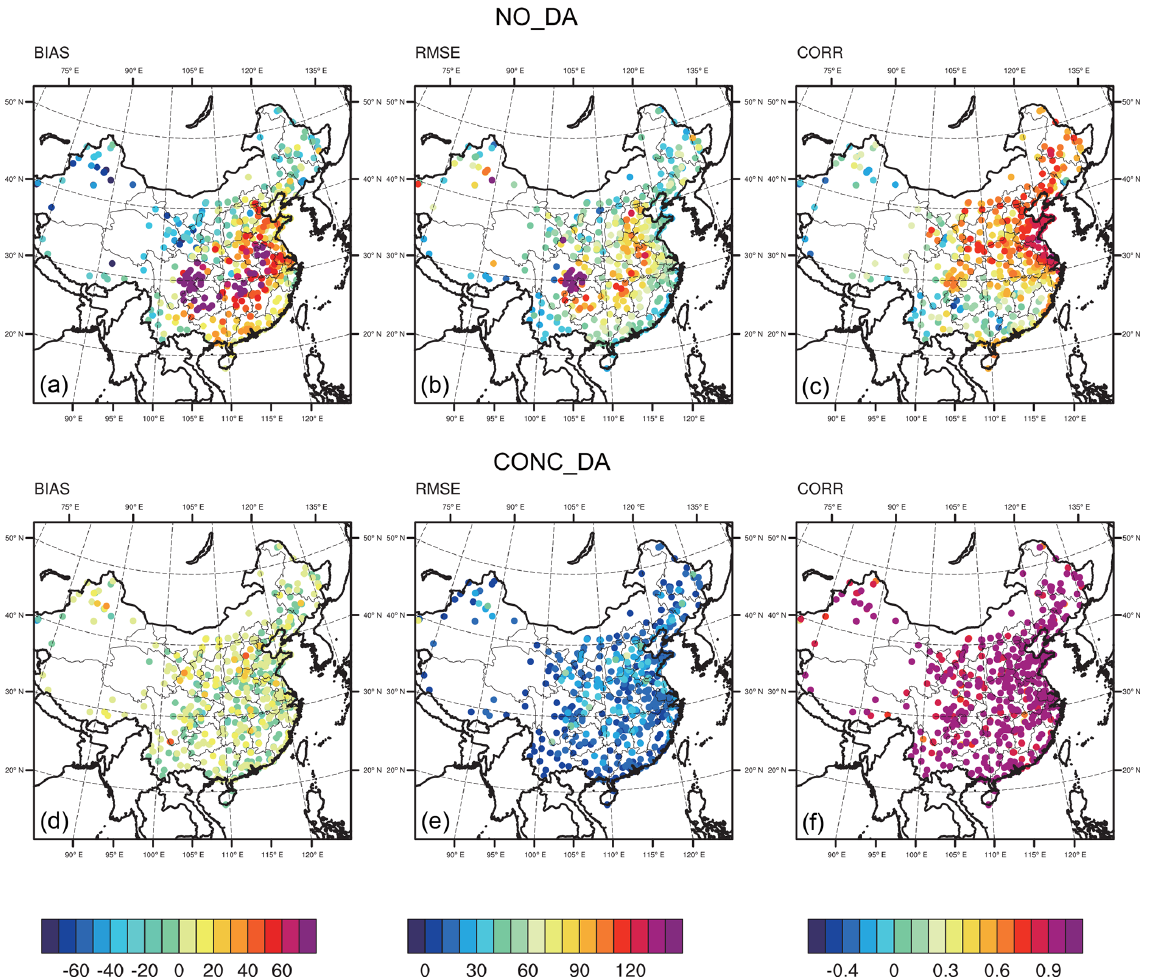
Figure 5. Spatial distributions of the statistics between the model simulations and observations for January 2015. On the top is NO_DA vs. observations, and on the bottom is CONC_DA vs. observations. BIAS is the model minus observation (a, d) , RMSE is the root-mean-square error (b, e) and CORR is the correlation coefficient ( c, f ; units are µgm − 3 for BIAS and